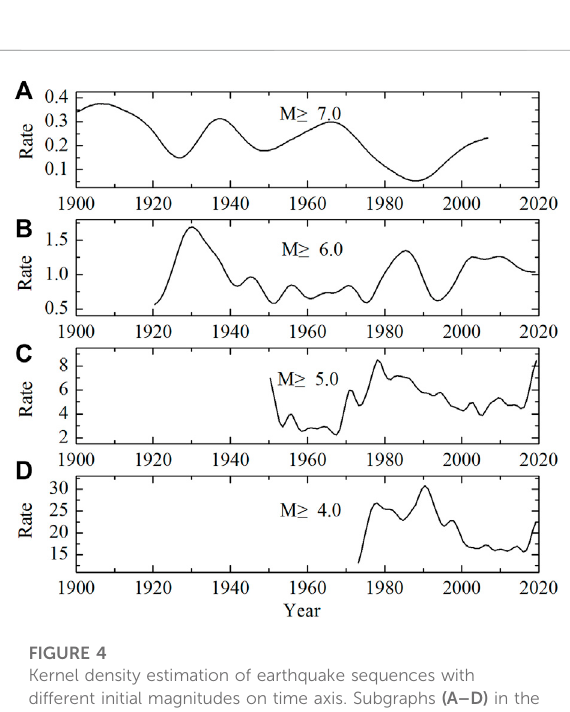
FIGURE 4 Kernel density estimation of earthquake sequences with different initial magnitudes on time axis. Subgraphs (A – D) in the fi gure are the time-varying curves of seismic rate with magnitudes M ≥ 7, M ≥ 6, M ≥ 5 and M ≥ 4,